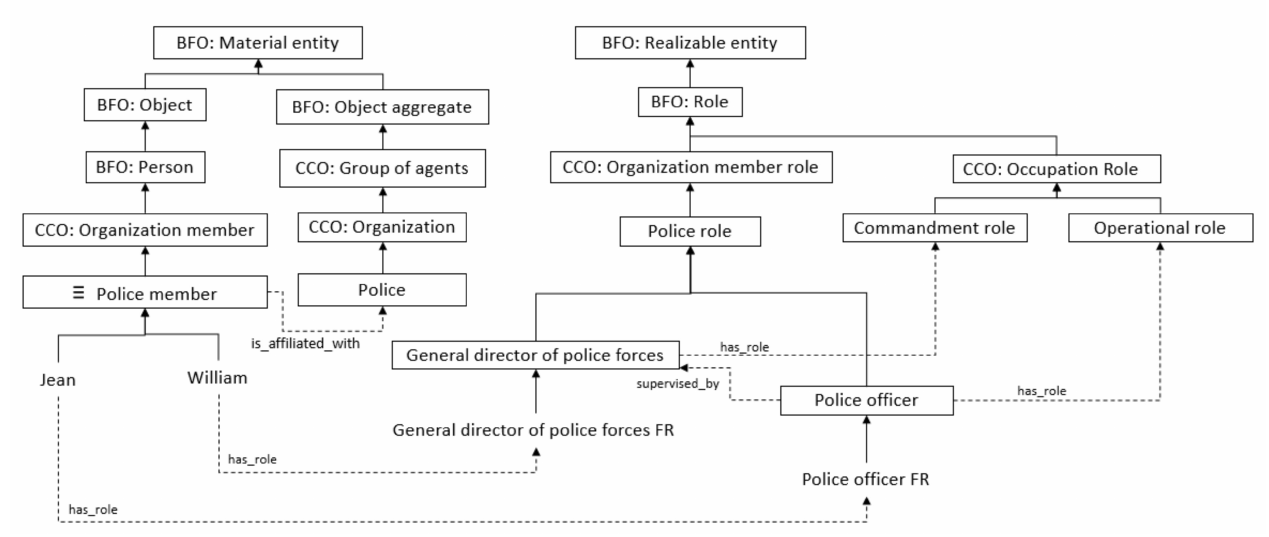
Figure 12. Definition of ERs’ roles in the Police